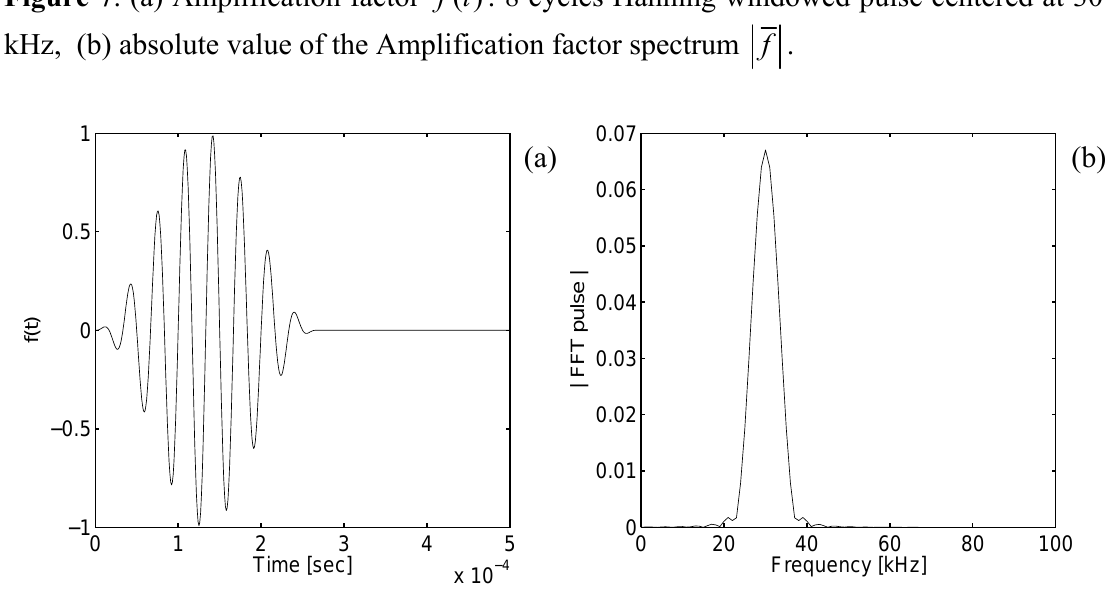
Figure 7 . (a) Amplification factor ( ) f t : 8 cycles Hanning windowed pulse centered at 30 kHz, (b) absolute value of the Amplification factor spectrum f .